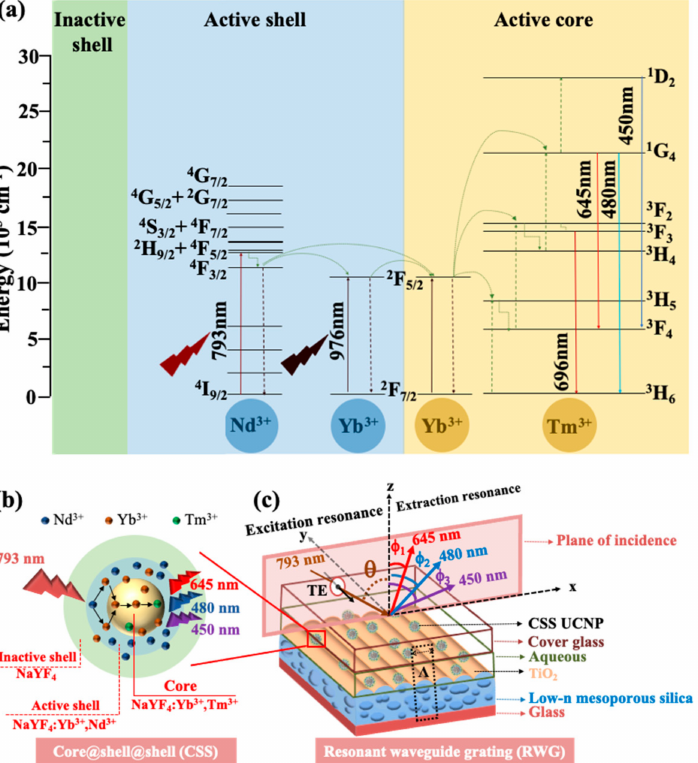
Figure 1. ( a ) Illustration of the proposed energy − level diagram describing the proposed UCL processes for Nd 3+ , Yb 3+ , and Tm 3+ ions. The full, zigzag, curved, and dashed arrows denote excitation, multiphonon relaxation, energy transfer, and emission processes, respectively. ( b ) Design of the core@shell@shell UCNPs. ( c ) Schematic of the UCNPs − deposited low − n RWG structure, in which the core@shell@shell UCNPs were deposited on the top surface of the low-n RWG structure by dip-coating method, followed by covering with aqueous solution. θ and φ i (i = 1, 2, 3) denote the angles of the excitation light and the emission light with respect to the surface normal, respectively. Λ denotes the grating period. The dashed rectangular indicates one unit cell for calculating the electric field intensity distribution in the RWG structure at resonance